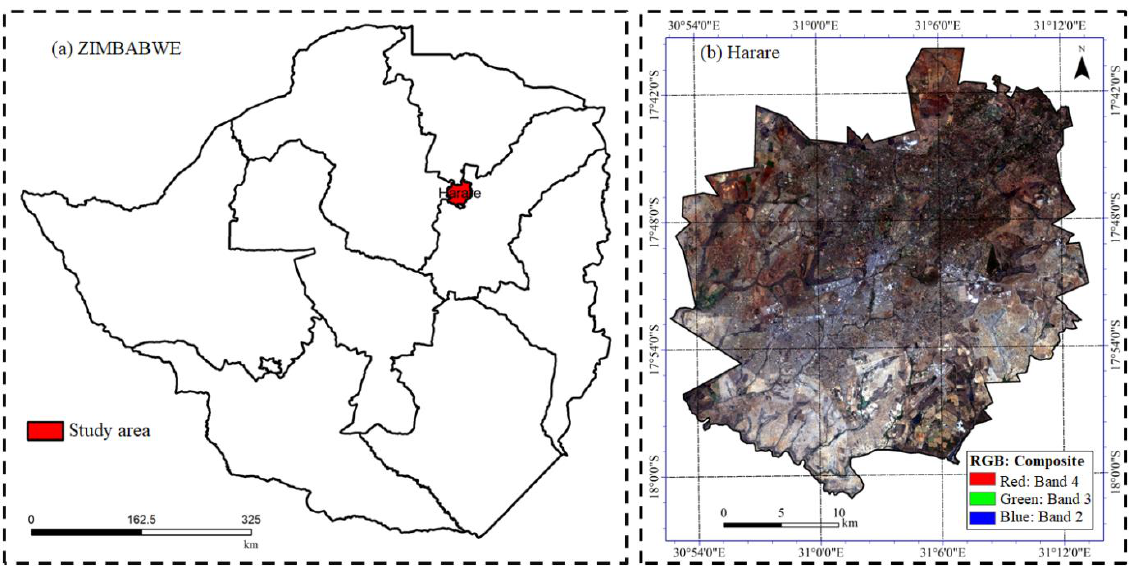
Figure 1. Location of the study area in Zimbabwe ( a ) and heterogeneity of land surface property using RGB = 432 of Landsat 8 data ( b ).